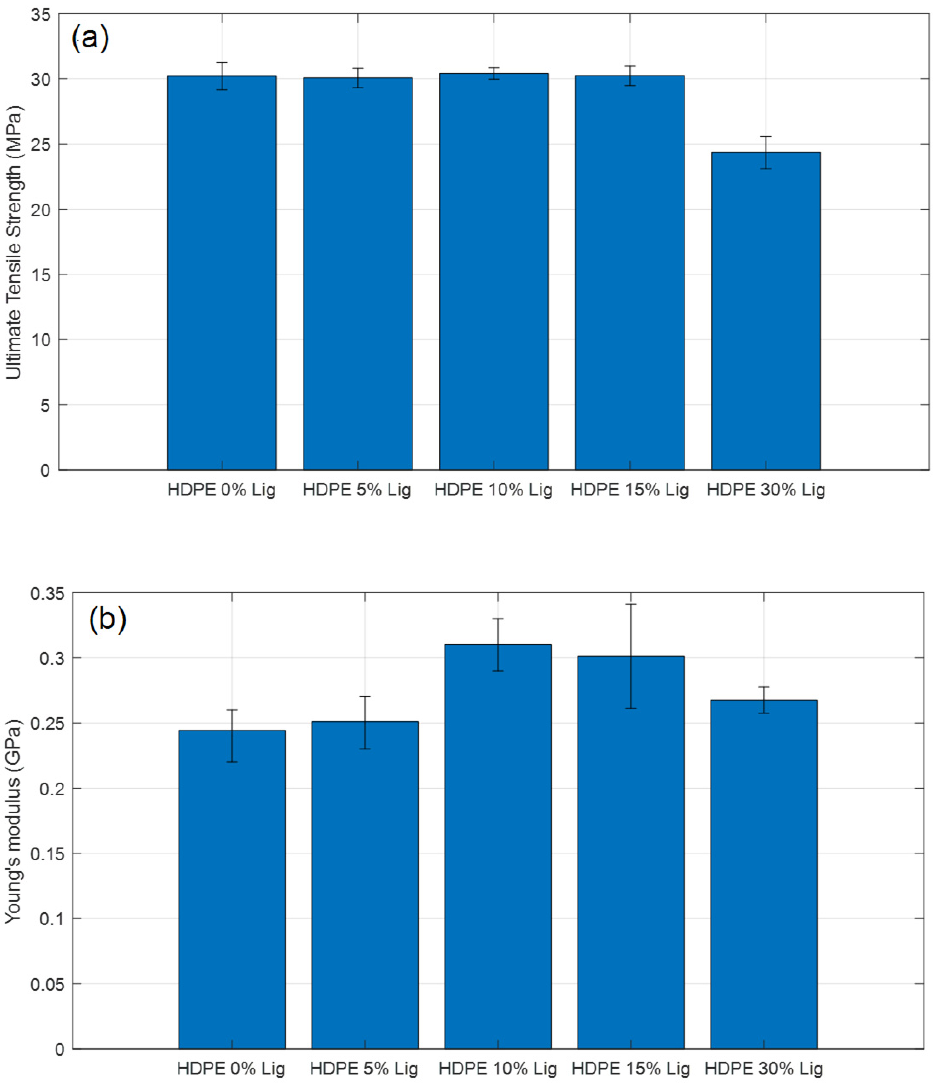
Figure 10. ( a ) Ultimate tensile strength and ( b ) Young’s modulus comparison of HDPE–lignin blend materials. Table 5. Comparison of tensile properties of HDPE–lignin blend. Blend